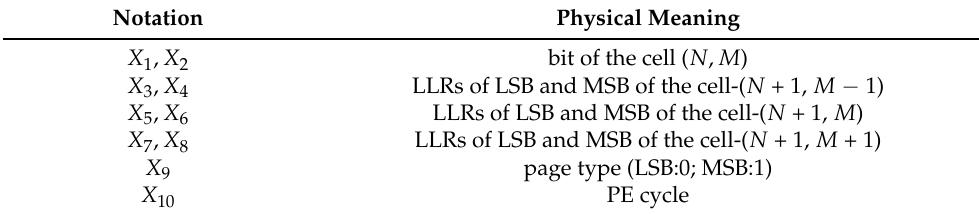
Table 1. Summary of input